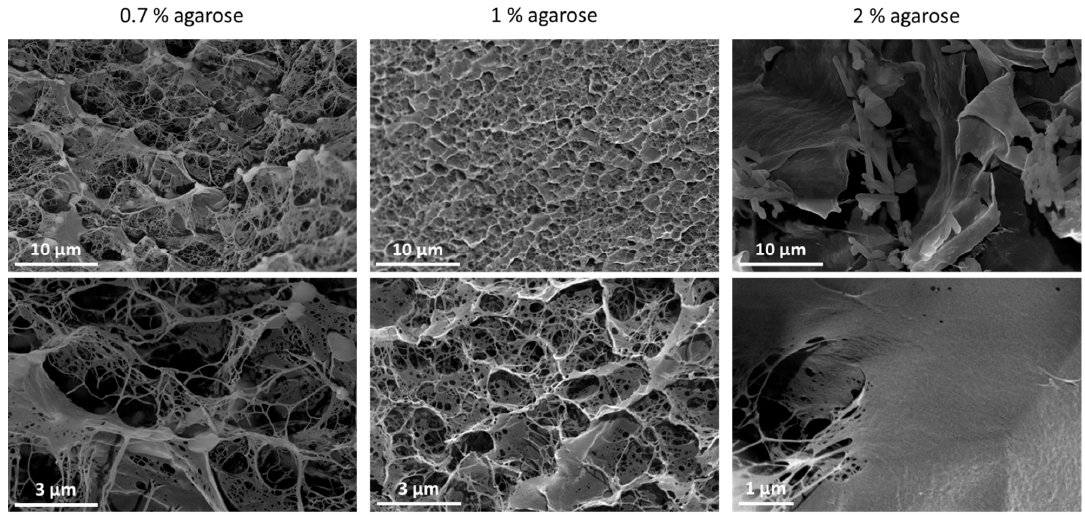
Figure 2. SEM images of 0.7%, 1%, and 2% agarose hydrogels.